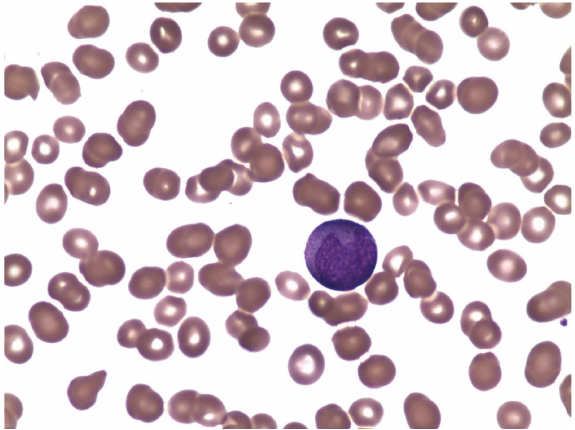
Figure 1: Peripheral blood film showing promyelocytes. The periph- eral blood film revealed frequent promyelocytes, most of them with multiple Auer rods. Flow cytometric analysis confirmed that these cells were immature promyelocytes expressing CD45 (dim) CD33 (dim), and CD13 and negative for CD34, HLADR, CD14, CD15, CD64, and CD16. Additional FISH studies confirmed the presence of t(15; 17) PML-RARA fusion seen in acute promyelocytic